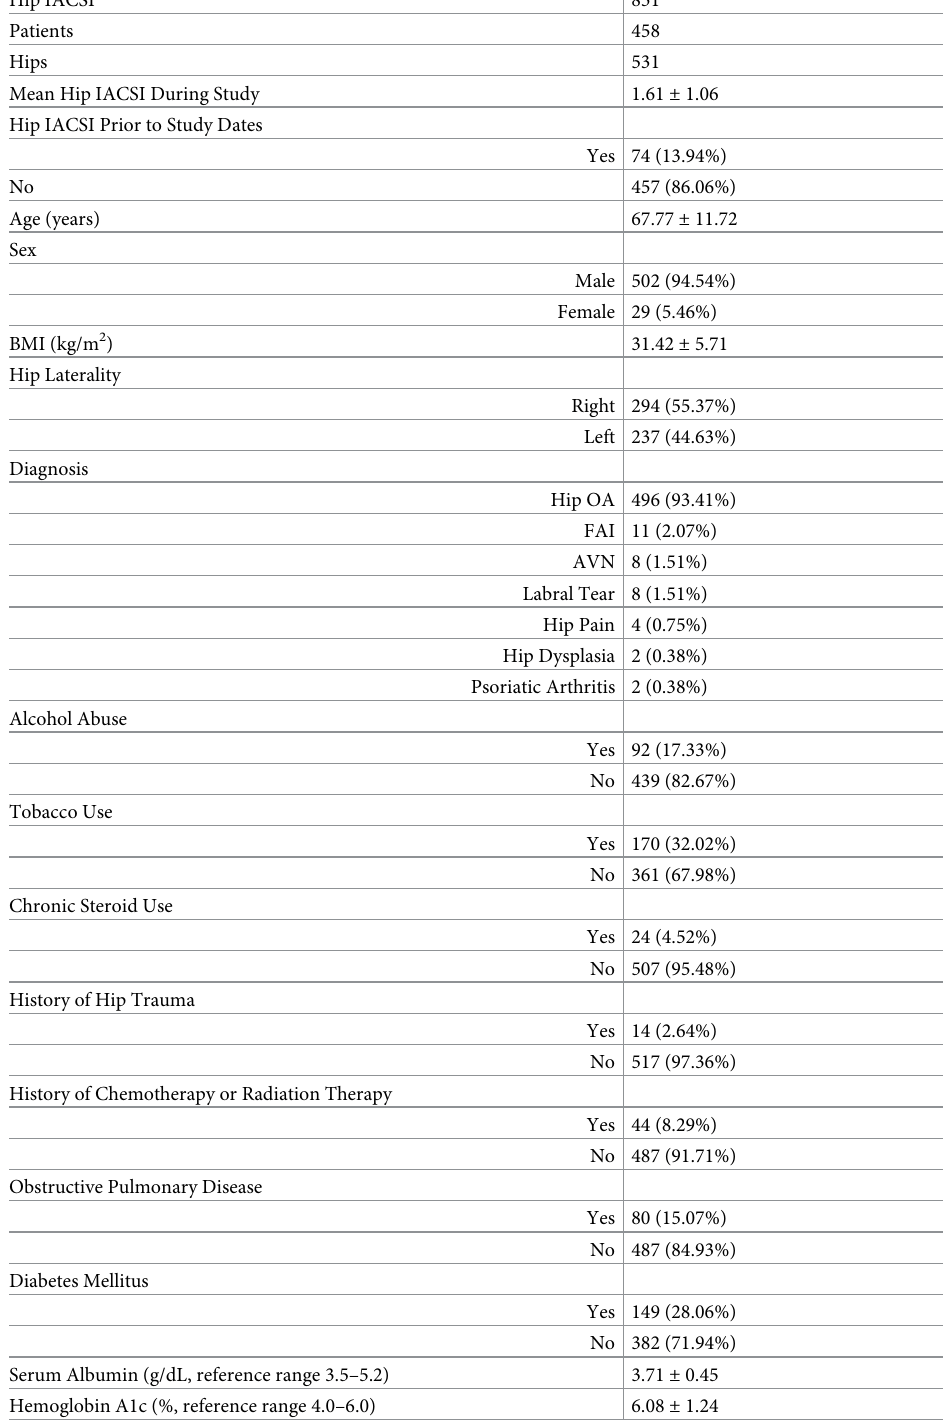
Table 1. Hip IACSI patient demographics and medical